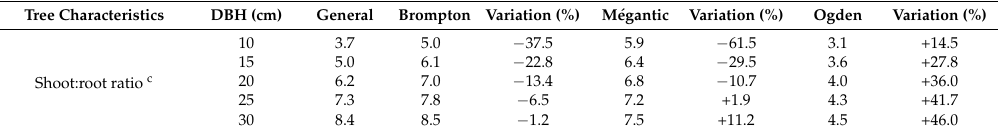
Tree Characteristics